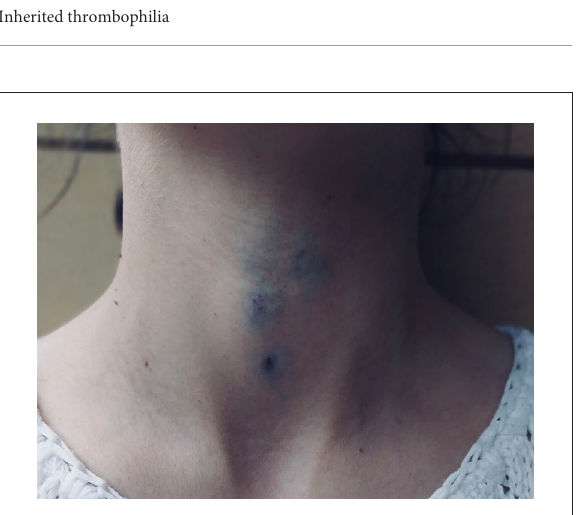
FIGURE1 Collateral variceal venous circulation of the neck due to the presence of internal jugular